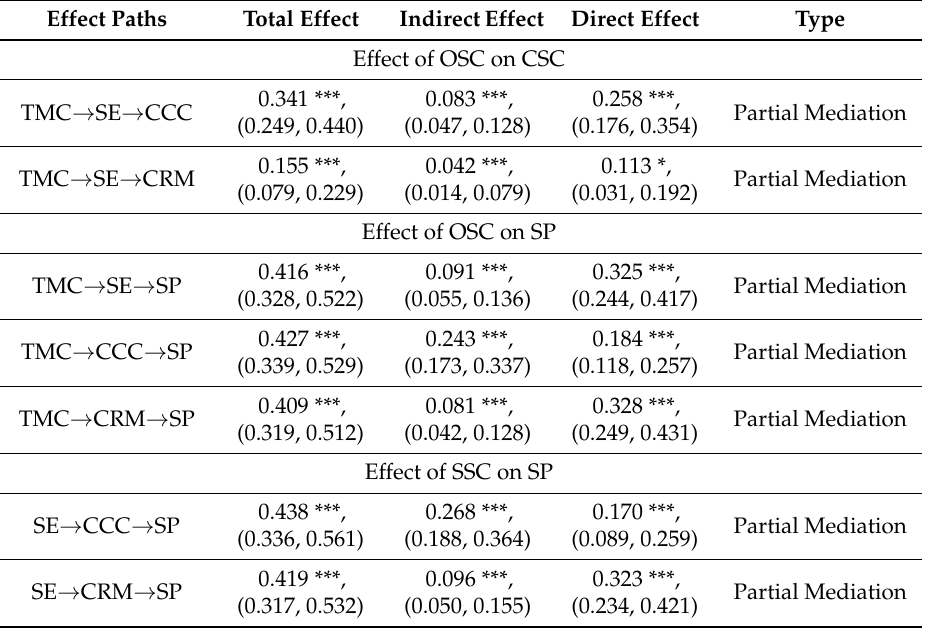
Table 5. Breakdown of effect